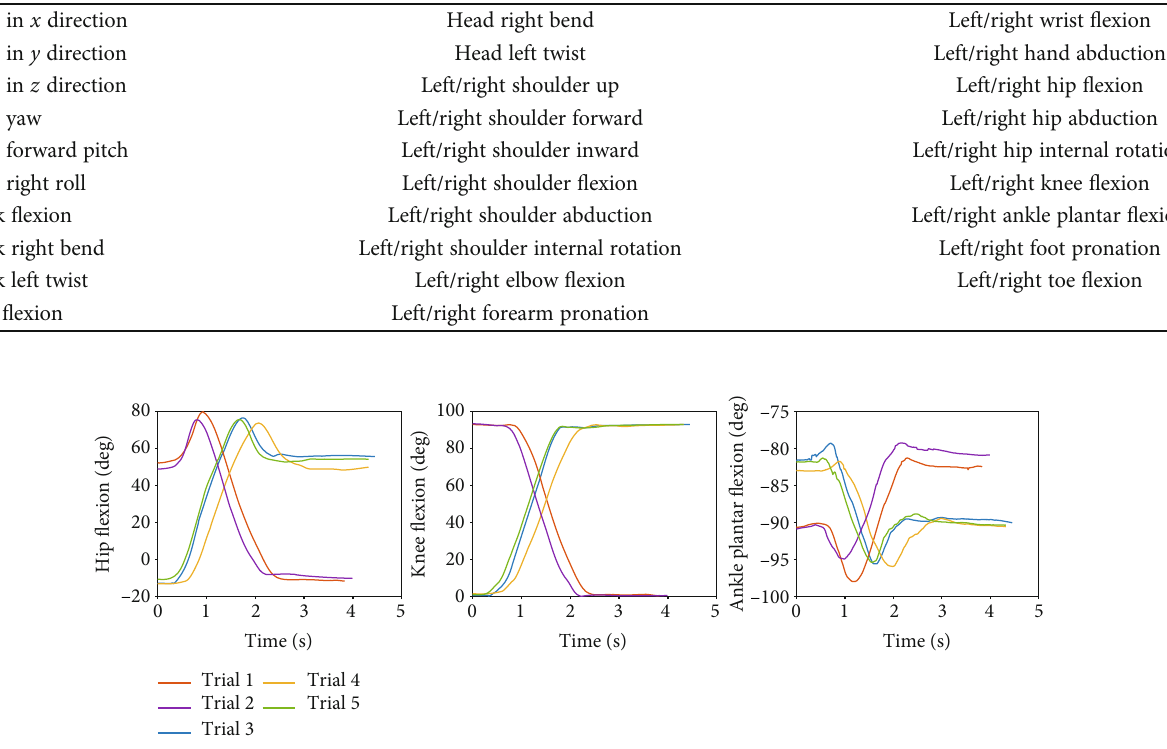
Figure 7: The fi rst two trials are sit-to-stand transitions and the other trials are stand-to-sit transitions. These results are taken from subject